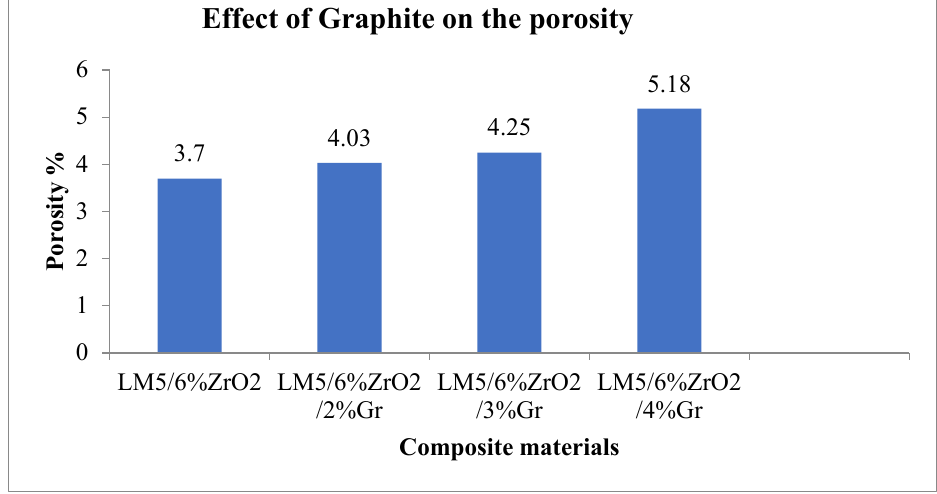
Figure 9. Effect of graphite on the porosity of composites.